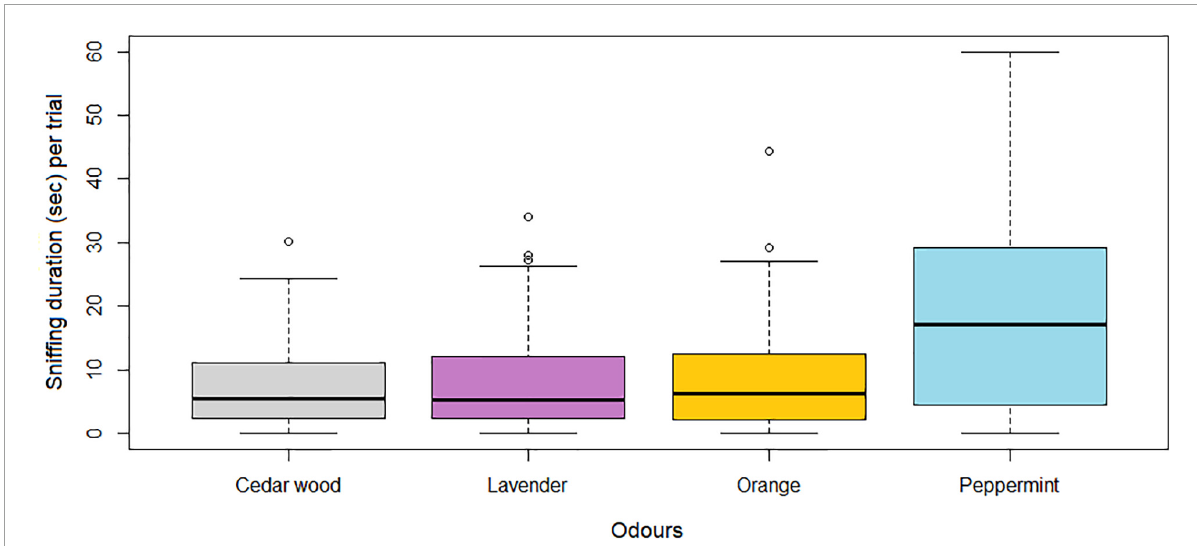
FIGURE3 Illustration of the total sniffing duration (seconds) of each odor per horse. Orange represent orange, light blue represents peppermint, purple represents lavender and light gray represents cedar wood. The boxes represent the 25, and 75% quartiles, the thick line inside the box represent the median and the dashed lines illustrate the